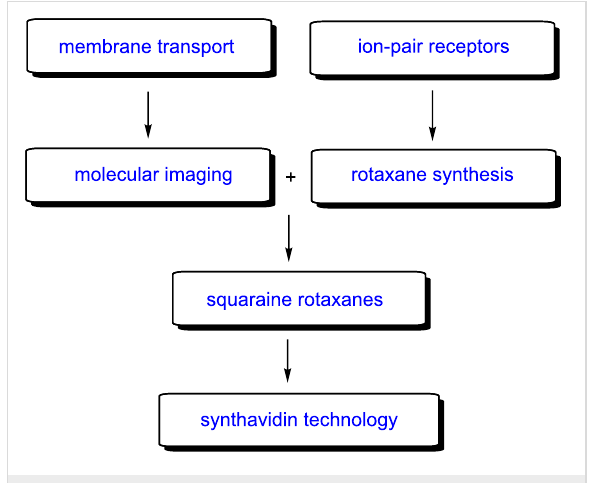
Scheme 1: Chronological progression of Smith group research